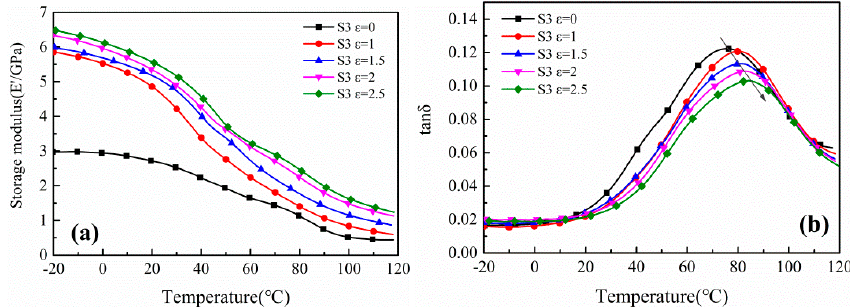
Figure 12. The ( a ) storage modulus vs. temperature and ( b ) tan δ vs. temperature curves of uniaxially stretched PA612/SiO 2 films . Table 3. The glass transition temperature of uniaxially stretched PA612/SiO 2 films.